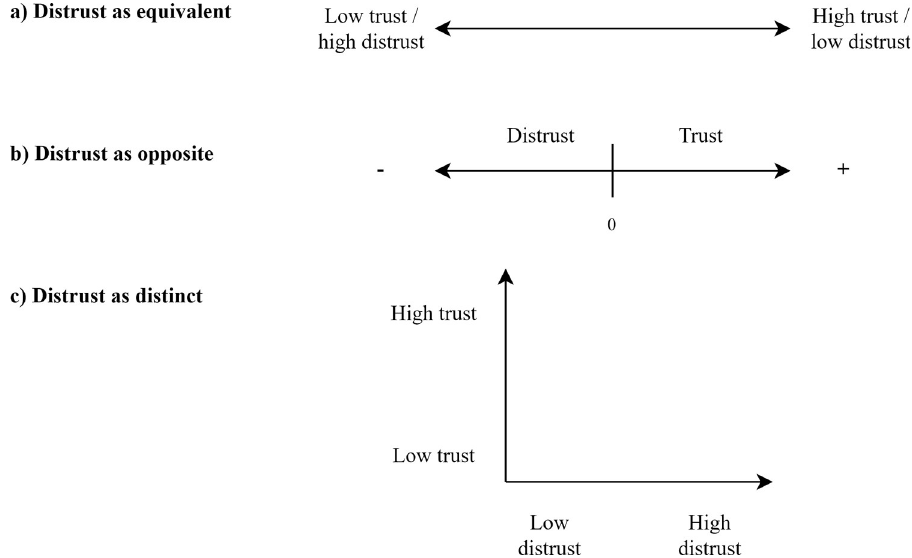
Fig 1. Three conceptualizations of distrust in relation to trust. (a) Low trust as equivalent to distrust. (b) Trust and distrust as opposites along the same continuum. (c) Trust and distrust as distinct and separate concepts (modified from